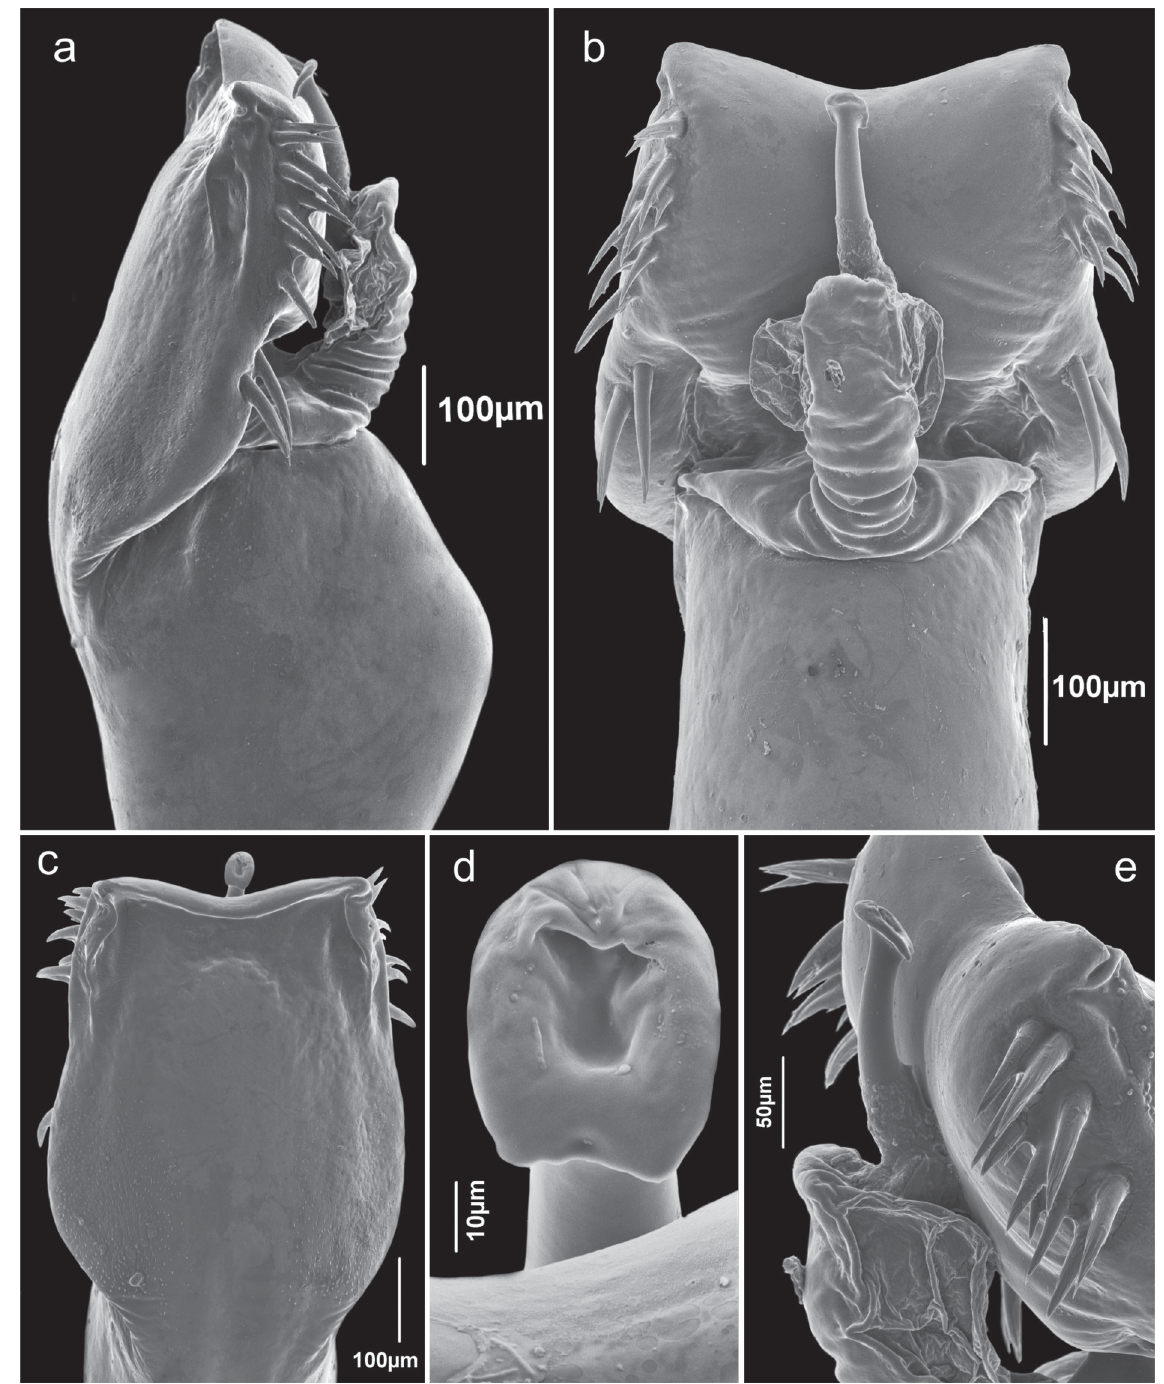
Fig. 10. Phalangodus cottus sp. nov., paratype, ♂ (MNRJ 17942), penis distal portion. a . Lateral view. b . Dorsal view. c . Ventral view. d . Stylar caps, ventrodistal view. e . Distal portion of the ventral plate and stylus, dorsolateral